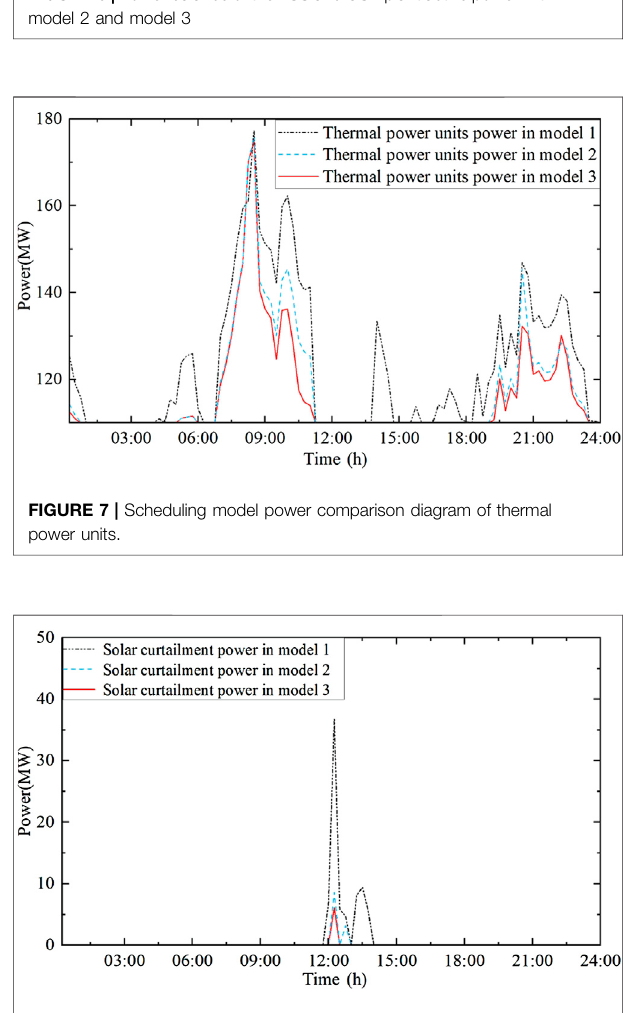
FIGURE 8 | Comparison diagram of solar curtailment power in the scheduling model.